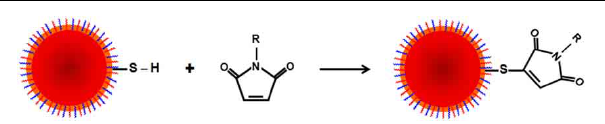
FIGURE 10 | Maleimide coupling reaction. Maleimide reacts with free sulfhydryl group(s), forming stable thioether linkages, at physiological pH. It is useful for bioconjugation of proteins with − SH groups and the coupling of two thiols to form a disulfide